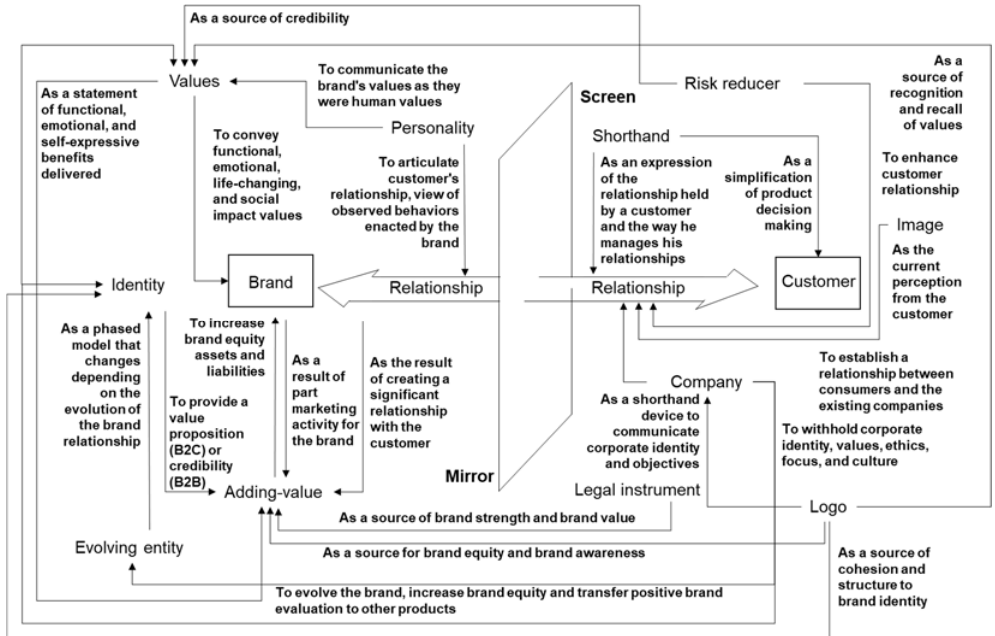
Figure 3. Brand dimension relationship diagram.